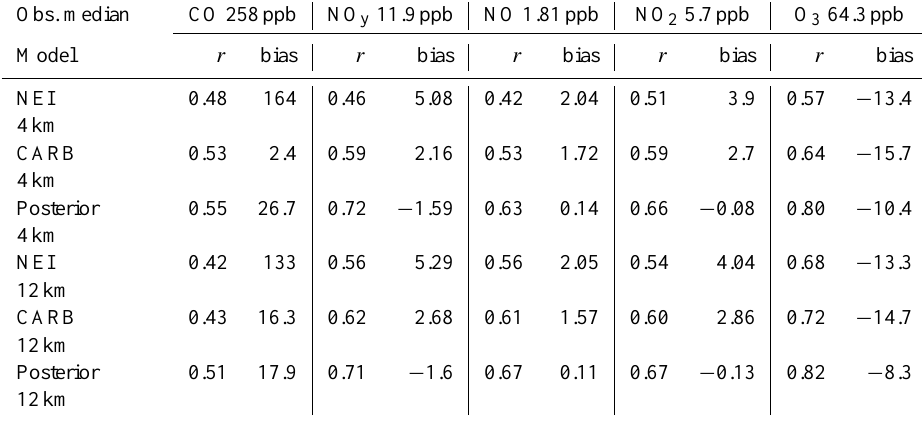
Table 7. Statistical summary for WRF-Chem simulations using the NEI 2005, the gridded CARB and posterior emissions at two model resolutions (4km and 12km) for five species. Comparisons are windowed for 10:00–18:00LT, 200m to 700m a.g.l., and a geographic window over the LA Basin described in the text. “ r ” is the Pearson correlation coefficient, and “bias” is the median bias in ppbv. Obs. median CO 258ppb NO y 11.9ppb NO 1.81ppb Model r bias r bias r bias r